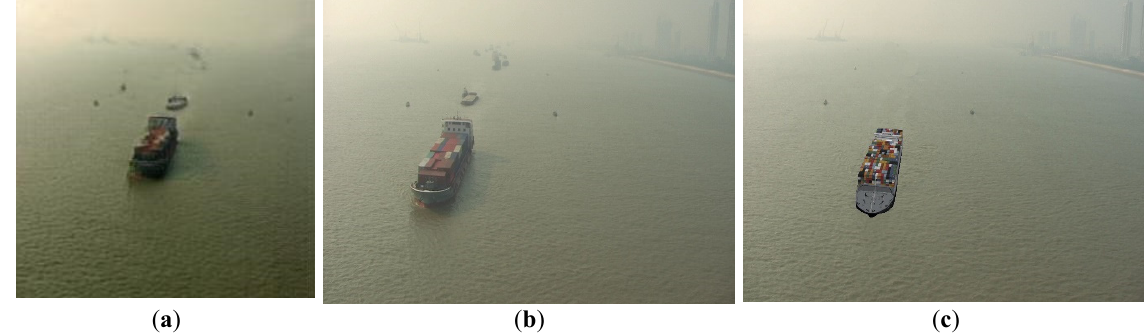
Figure 15. The simulation ship image generated by different methods: ( a ) the simulation ship image generated by CycleGAN; ( b ) the real ship image; ( c ) the SRS image.